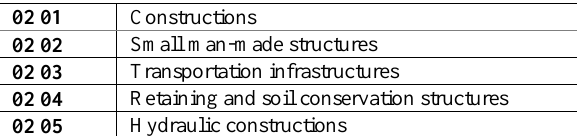
Table 2. The admissible values for the second level of the ‘02’ branch